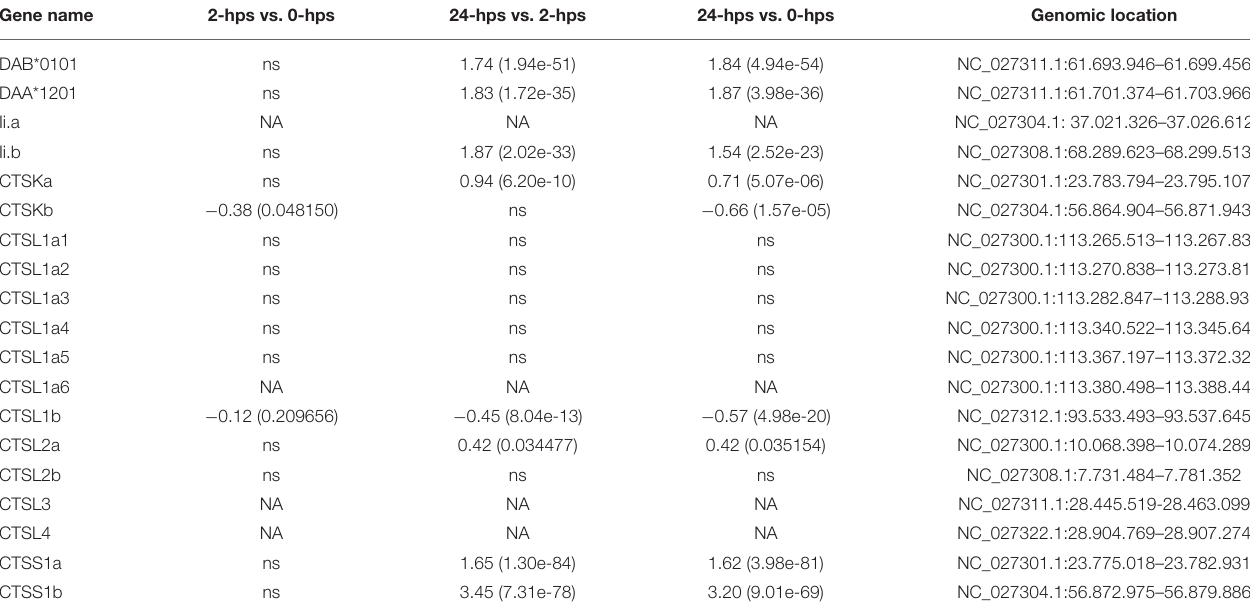
TABLE 4 | Log 2 fold change with adjusted P -values for selected MHCII pathway